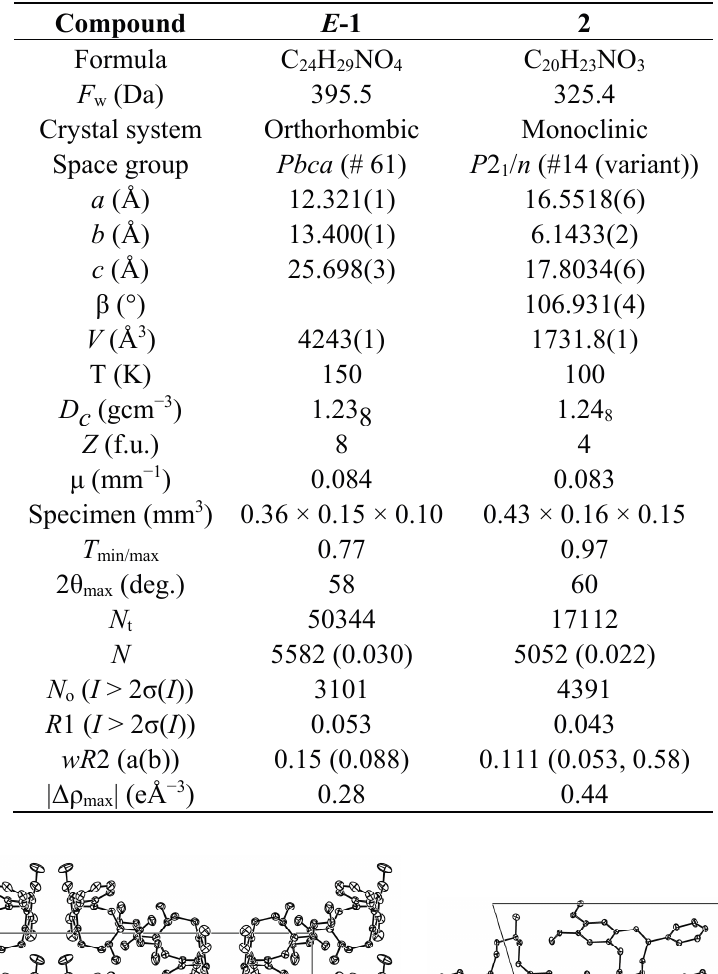
Table 3. Crystal refinement data, E - 1 , 2 .